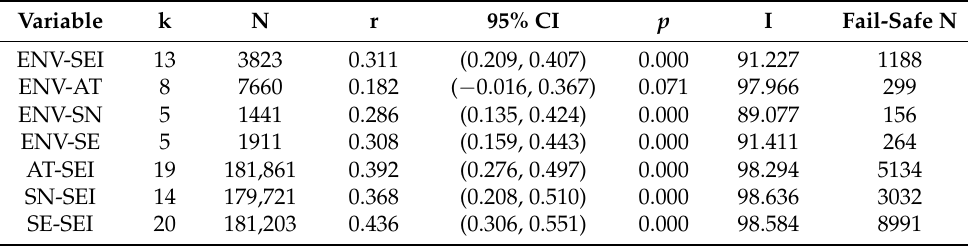
Table 1. Results of the meta-analysis on the main